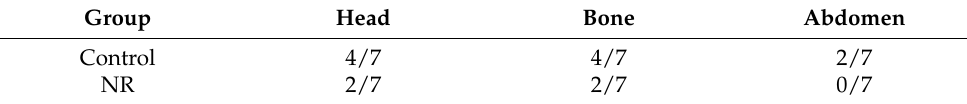
Table 2. Incidence of metastasis to different sites. Group Head Bone Abdomen Control